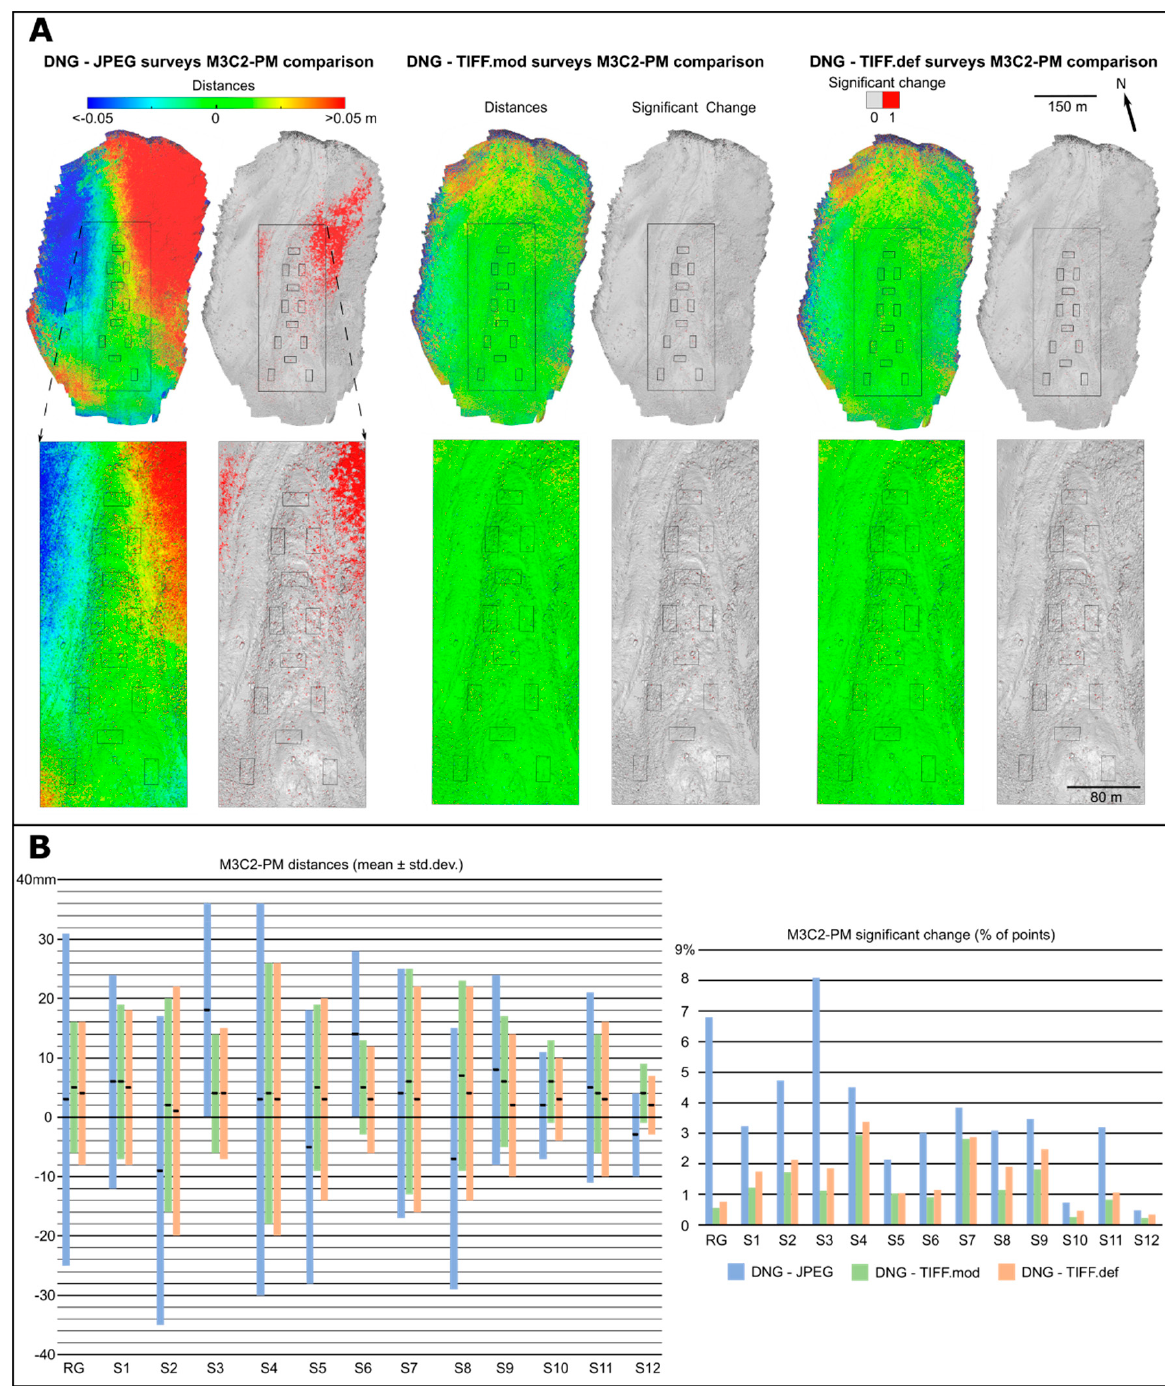
Figure 6. M3C2-PM 3D comparisons between SfM surveys. ( A ) M3C2-PM distances values and distribution (distances less than − 0.05 m are shown in blue and distances greater than 0.05 m in red). Significant change values and distribution (significant changes are shown in red). ( B ) M3C2-PM distances (mean and SD) and significant change percentages in the different rock glacier sectors. Table 5. Summary of 3D comparisons between the photogrammetric surveys of the different image sets in the areas studied. Mean and standard deviation of the differences are shown, as well as the percentage of points where the differences are significant (95% confidence level).